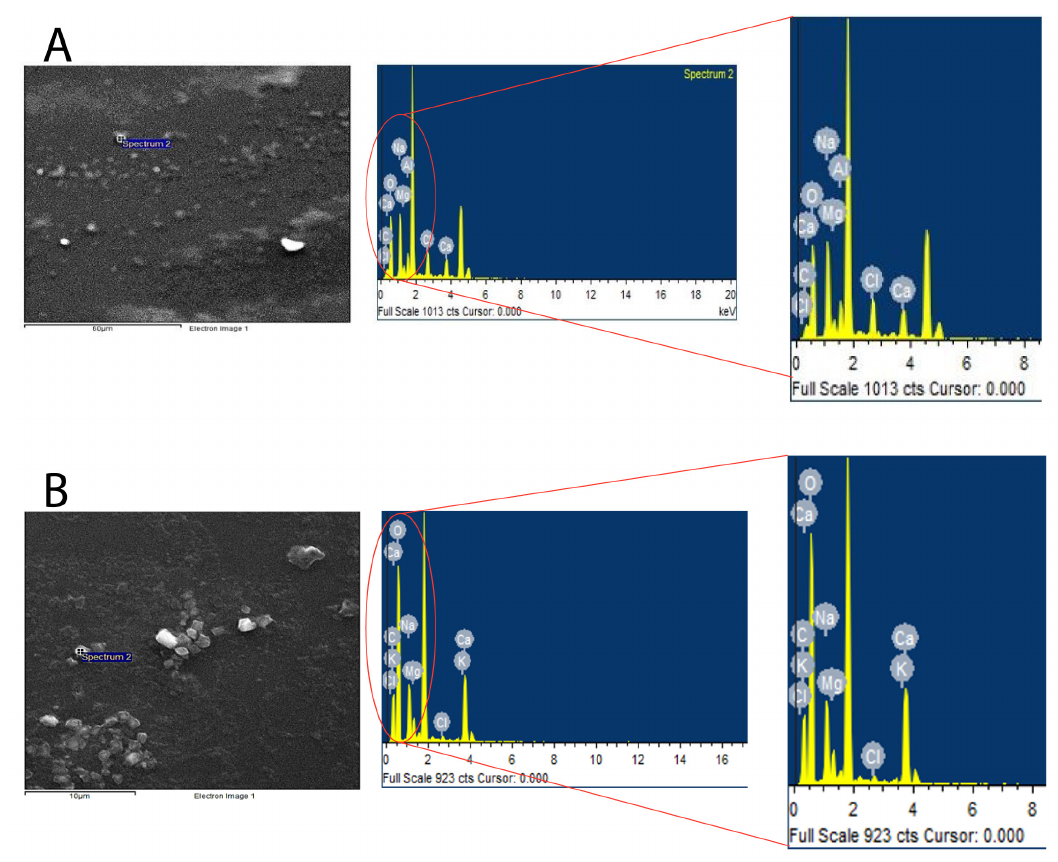
Figure 7. Energy dispersive spectroscopy (EDS) ( A ) Blank-SLNPs, ( B ) SLNP-TMZ. An increase in the peaks of Hydrogen and Oxygen could be observed in the spectrum of SLNP-TMZ, which could be explained by the incorporation of TMZ in the